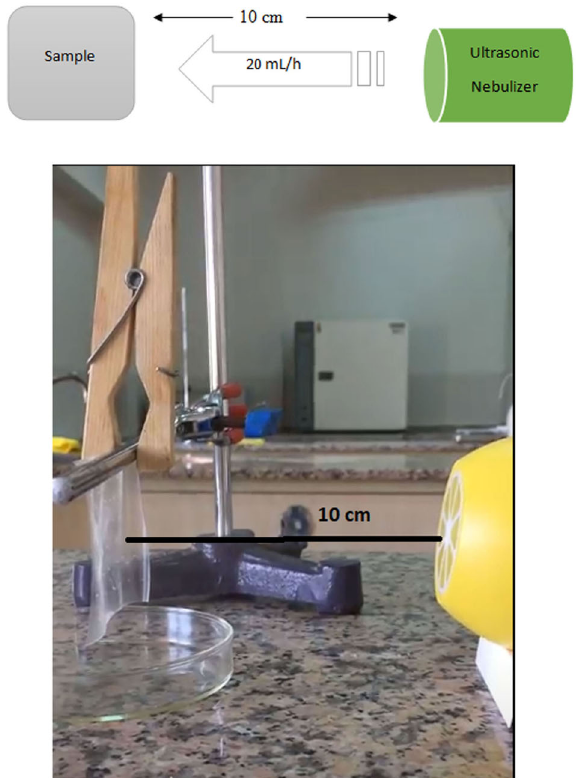
Fig. 9 Polypropylene sample. The samples produced from the extruder in the form of fi lm strips were cut rectangularly in an area of 50 cm 2 . Holes were opened on the samples with a pin tip to facilitate the air fl